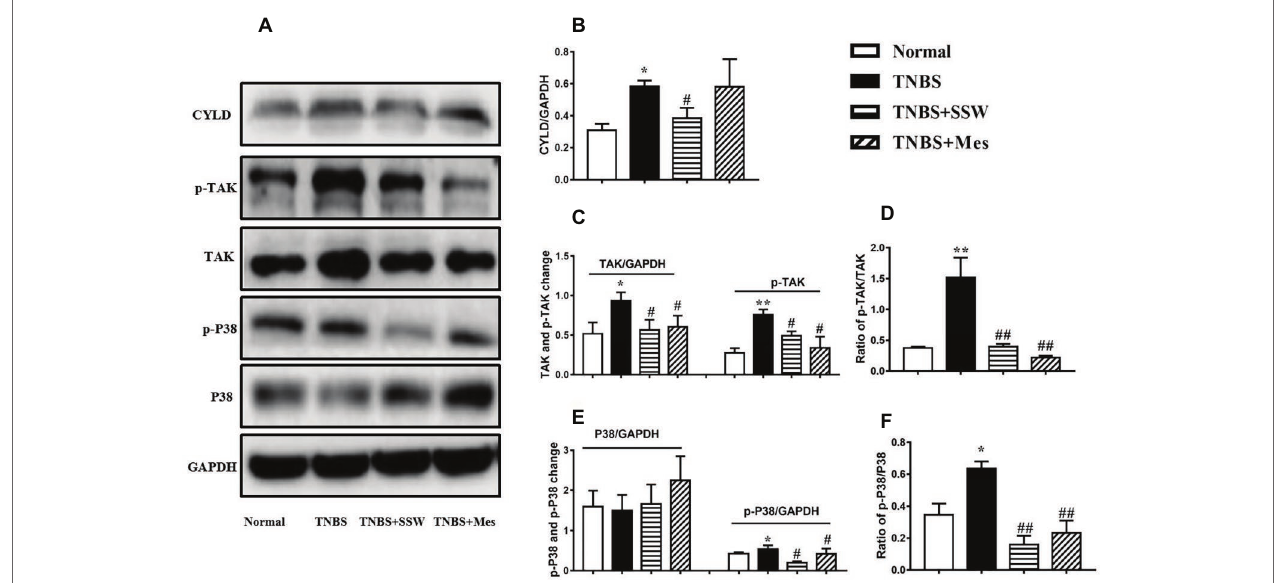
FIGURE 6 | Western blot analysis of CYLD, p-TAK, TAK, p-P38, and P38. (A) Western blotting of CYLD, p-TAK, TAK, p-P38, and P38. (B) Quantitative analysis of CYLD. (C) Quantitative analysis of p-TAK and TAK. (D) Ratio of p-TAK/TAK. (E) Quantitative analysis of p-P38 and P38. (F) Ratio of p-P38/P38. Data were presented as mean ± SEM ( n = 6). * p < 0.05 and ** p < 0.01 versus the Normal group; # p < 0.05 versus the TNBS